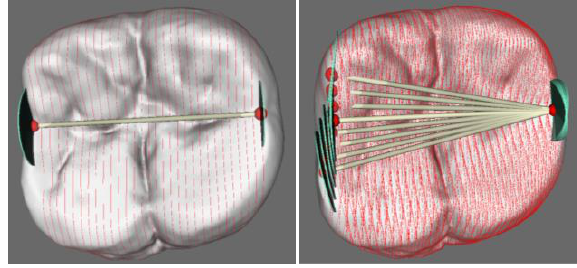
Figure 9. Varieties of odontotomic directions.